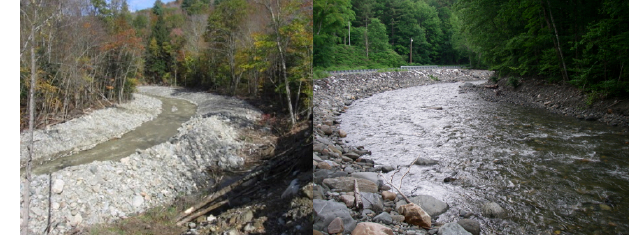
Fig. 3 . Chickley River after the channelization; approximately eight km of river were dredged and